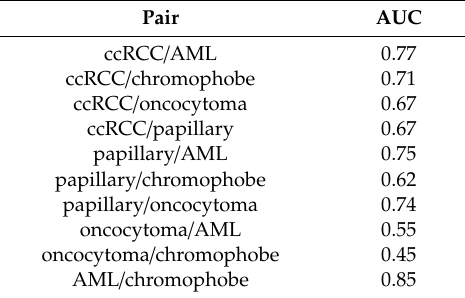
Table 4. Pairwise discrimination performance of the extreme gradient boosting algorithm in the full cohortwithSMOTEandwithoutfeatureselection.Themulti-classAUCisbasedonaveragingAUCsfrom all pairwise subtype comparisons. This table shows the mean AUC from these pairwise comparisons.